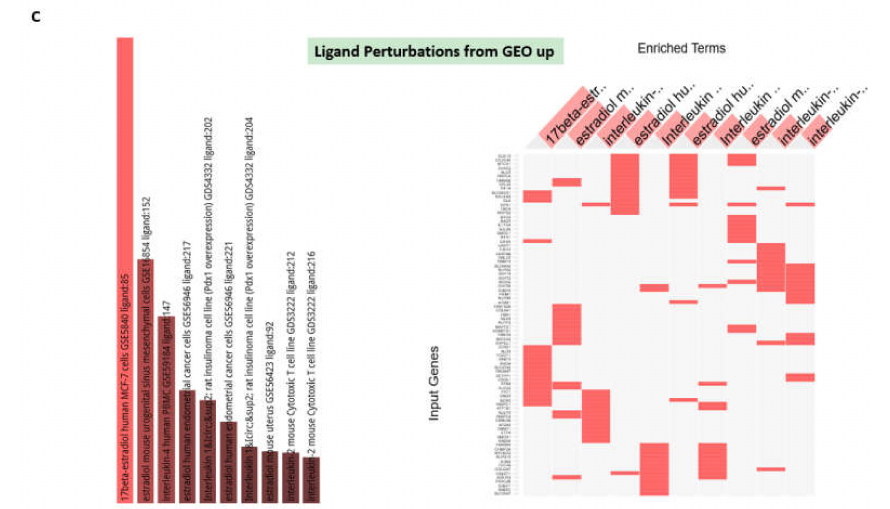
Figure 5. E ff ects of estradiol on expression of genes encoding human prey proteins of SARS-CoV-2. ( A ) Estradiol alters the expression of 203 of 332 (61%) of genes encoding human prey proteins for 26 of 27 (96%) of SARS-CoV-2 proteins. Percent values refer to the fractions of targets a ff ected by the estradiol based on gene expression profiling experiments. Both downregulated and upregulated genes were scored assuming that expression changes would alter the stoichiometry of viral protein / human prey protein interactions. Numerical values next to each viral protein names indicate the number of a ff ected target protein-encoding genes. Panels ( B ) and ( C ) reports the results of GSEA of the 332 genes in the Ligand Perturbations from GEO of downregulated ( B ) and upregulated ( C ) genes. Note marked representations of the estradiol records among top 10 significantly enriched entries of endogenous